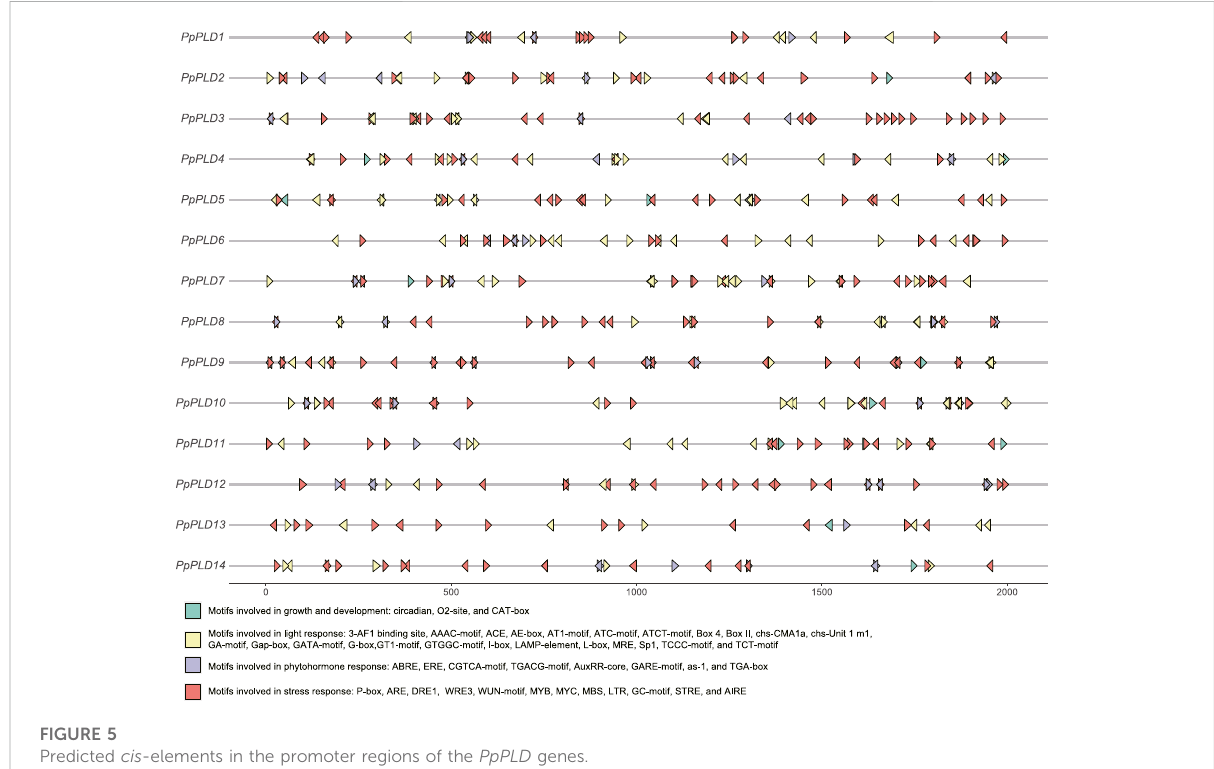
FIGURE 5 Predicted cis -elements in the promoter regions of the PpPLD